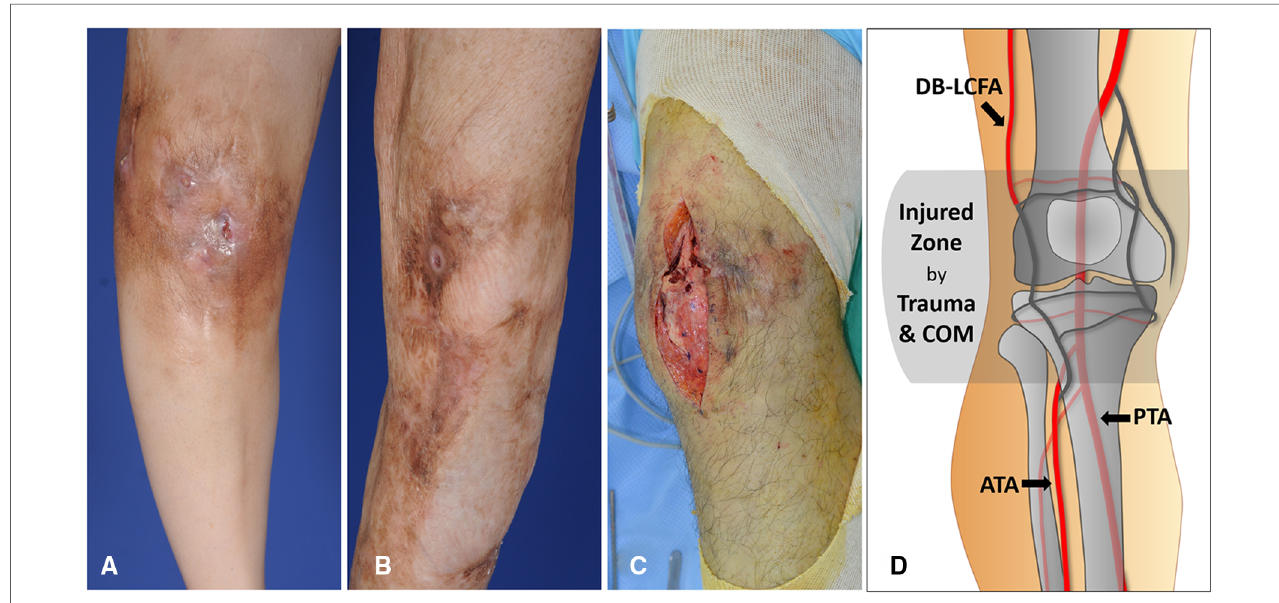
FIGURE 2 Damaged soft tissues around the knee caused by repetitive treatment of chronic posttraumatic osteomyelitis (COM) ( A ) A 49-year-old woman had a deteriorating wound around the knee accompanied by pus drainage due to osteomyelitis. The skin discoloration and thinning resulting from chronic in fl ammation are observed. ( B ) A 43-year-old man showed improvement in wound status without any discharge. Extensive scar formation following multiple debridement of COM is identi fi ed around the knee. ( C ) Destructed soft tissues mixed with scars was exposed during debridement of COM in a 39-year-old man. ( D ) Most of the arteries in the genicular arterial network are possibly damaged and unusable as recipient vessels because they are likely to be traumatized by initial trauma and COM. On the contrary, descending branch of lateral circum fl ex femoral artery (DB-LCFA), anterior tibial artery (ATA), and posterior tibial artery (PTA) tend to be safe from the traumatic damage due their deep location outside the injured zone and protection by